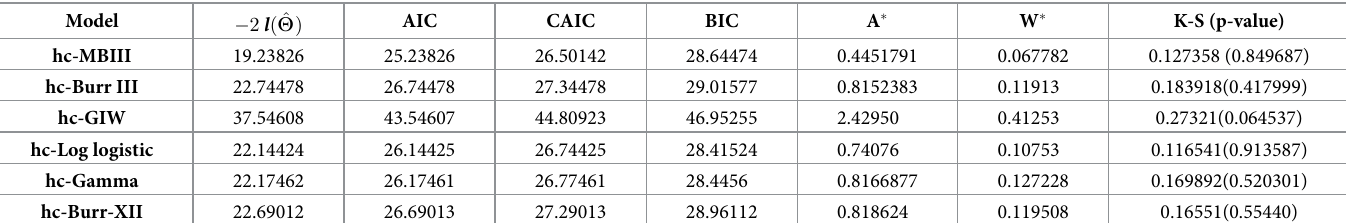
Table 3. (cid:0) 2 l ð ^ Y Þ , AIC, CAIC, BIC, A � , w � , K-S (p-values) for eye data. Model